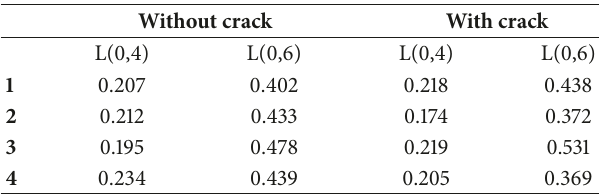
Table 1: Relative amplitudes of L(0,4) and L(0,6) without and with crack when the rotor is at